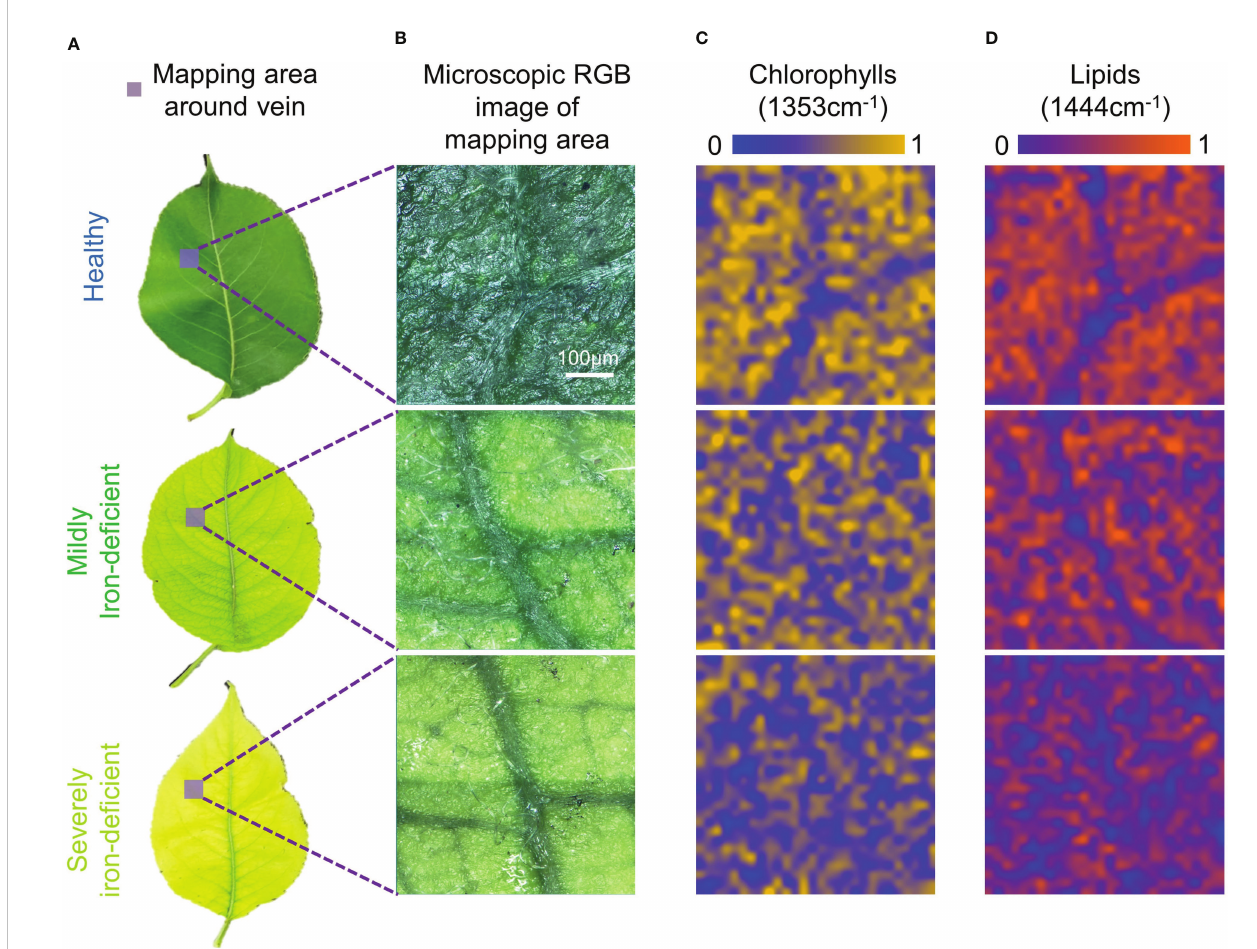
FIGURE 4 Visible light images and Raman spectral images of vein-region components of leaves with differing degrees of iron de fi ciency. (A) Visible light images of healthy and iron-de fi cient leaves; (B) Microscopic visible light images of the vein-mapping regions; (C) Pseudo-color maps of chlorophylls spatial distribution in the vein-mapping regions; (D) Pseudo-color maps of lipids spatial distribution in the vein-mapping